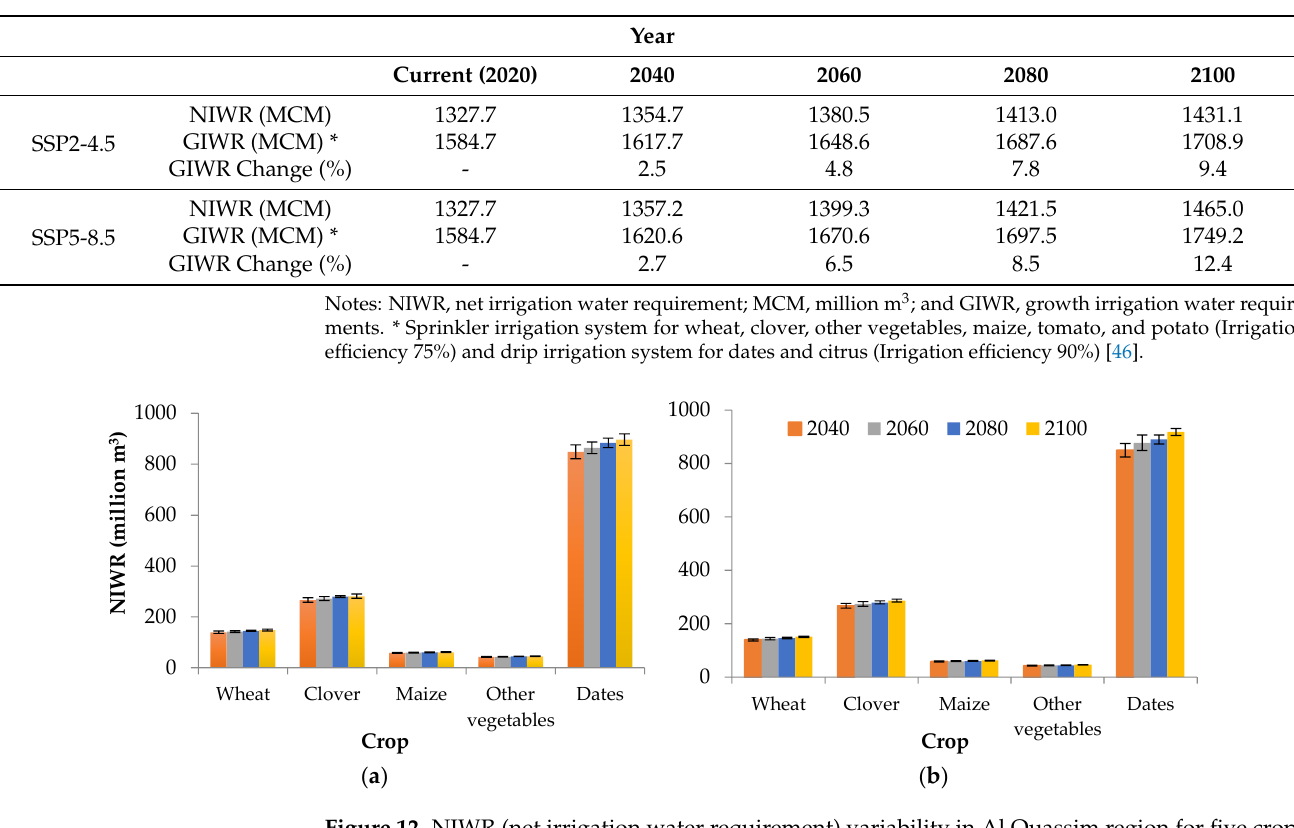
Table 8. Averaged net irrigation water requirements (NIWR) and growth irrigation water require-